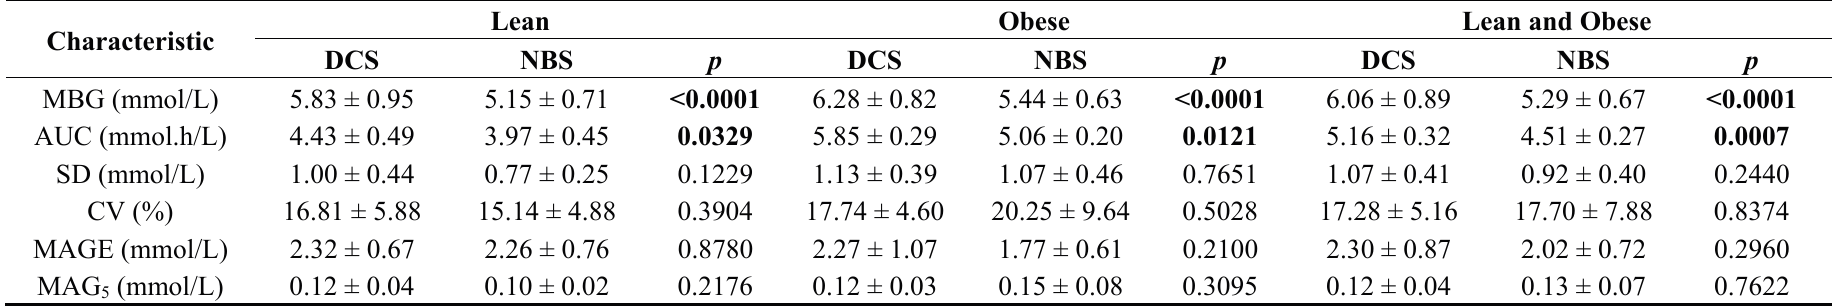
Table 2. Effects of beverages containing native banana starch (NBS) or digestible corn starch (DCS) in glycemic characteristics based on continuous glucose monitoring